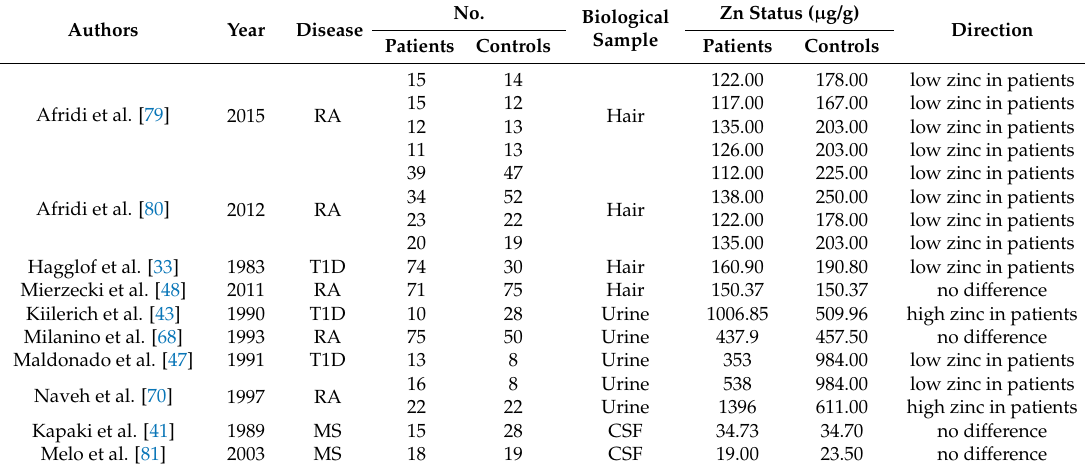
Table 3. Characteristics of selected studies included in meta-analysis in reference to hair, urine and CSF